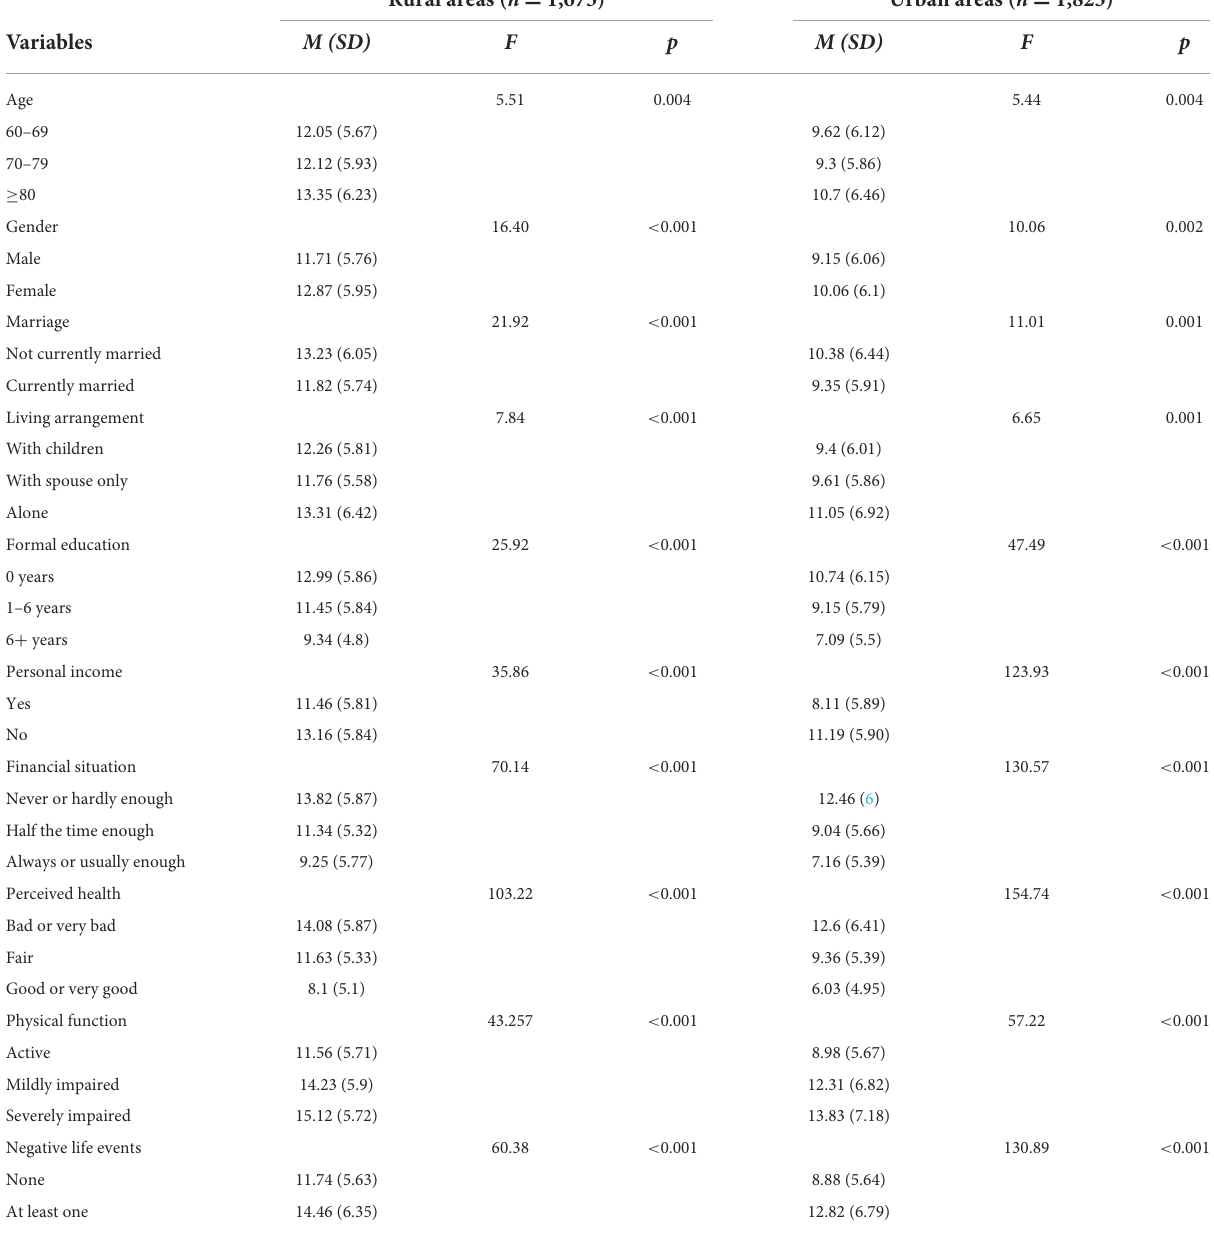
TABLE 2 Bivariate analyses of association between depressive symptoms and related factors. Rural areas ( n = 1,675) Urban areas ( n =